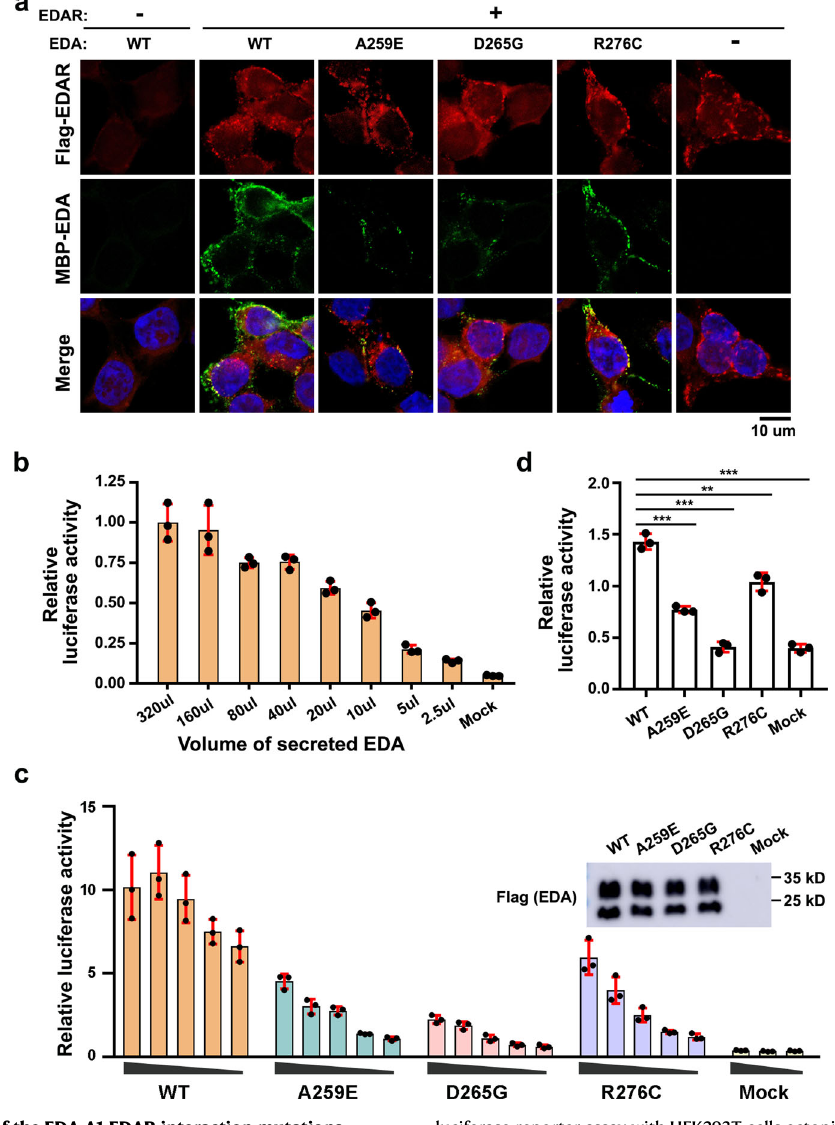
Fig. 5 | Functional analysis of the EDA·A1-EDAR interaction mutations. a Immuno fl uorescencestainingshowingthebindingofEDA·A1 THD variantstoEDAR on the cell membrane. MBP-EDA·A1 THD , full-length EDAR-Flag and DNA were stained in green, red and blue, respectively. Scale bar: 10 µ m. b Luciferase reporter assayshowsthatsupplementedWTEDA · A1 THD activatesNF- κ Bsignalingpathwayin a dose-dependent manner in HEK293T cells ectopically expressing full-length EDAR. Data are presented as the mean±SEM for n =3 independent